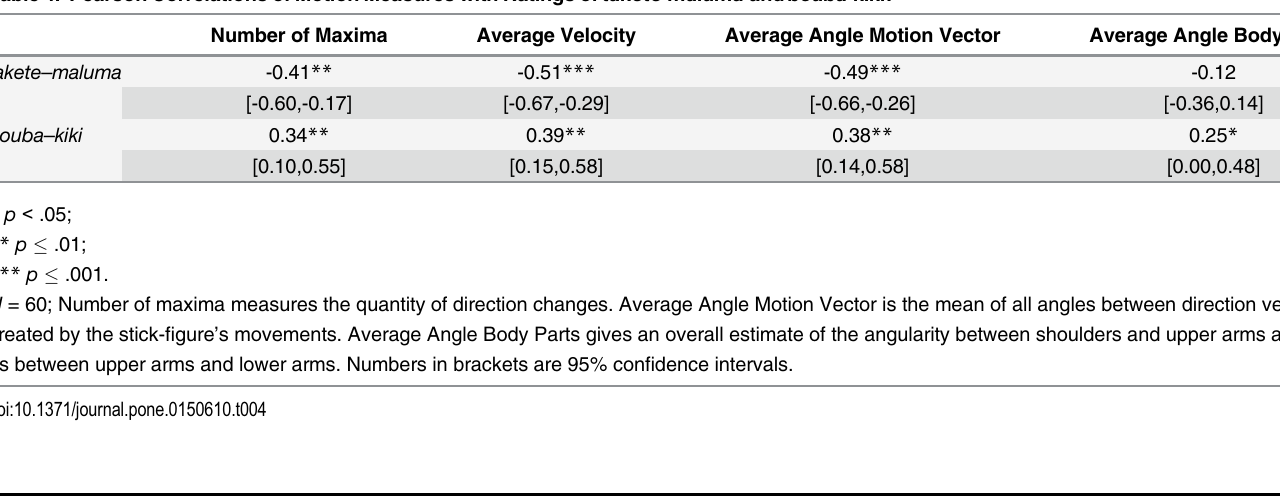
Table 4. Pearson Correlations of Motion Measures with Ratings of takete - maluma and bouba - kiki